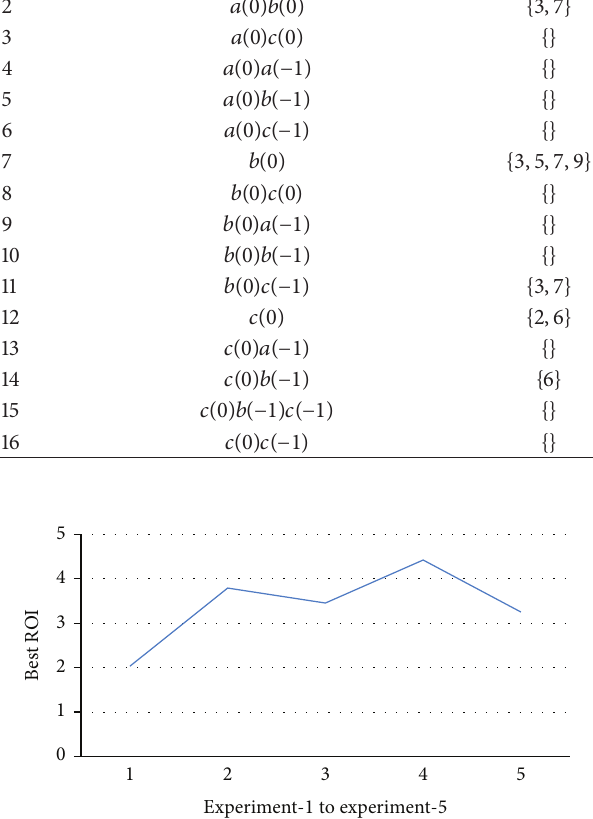
Figure 11: The best ROIs from five different price